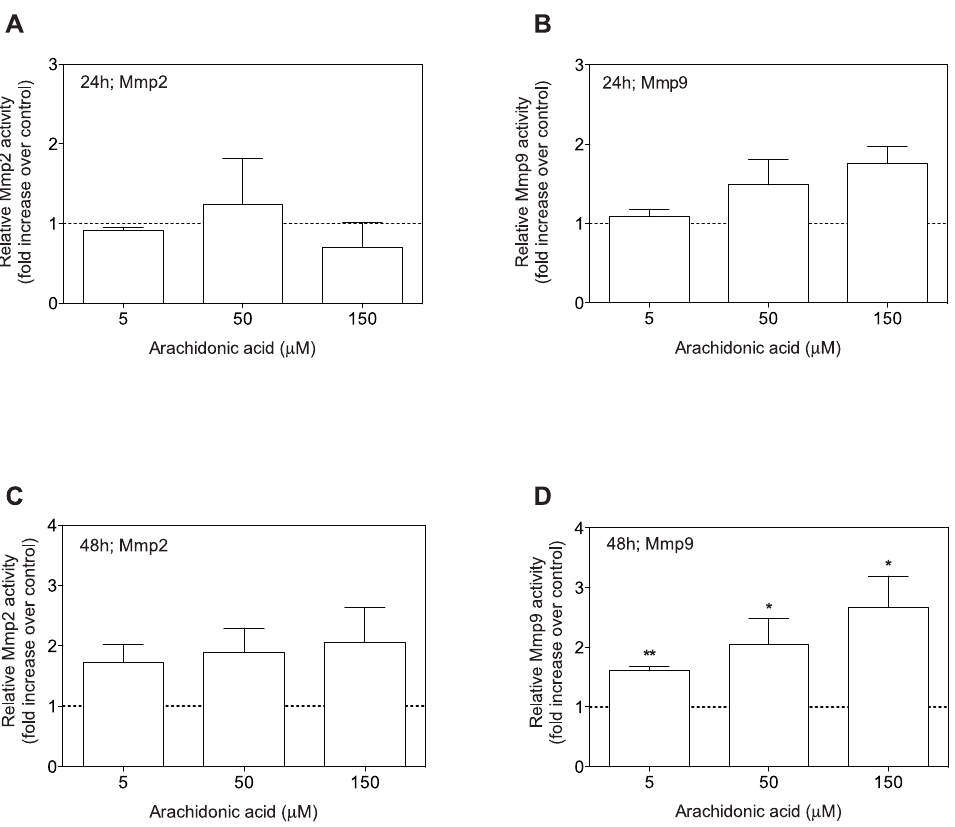
Figure 6. In-vitro exposure of scales to arachidonic acid. Semiquantitative analysis of gelatinolytic matrix metalloproteinases of culture medium after in vitro exposure of ARA for 24 hours ( A and B ) and 48 hours ( C and D ). A : ARA has no effect on Mmp2 activity after 24 hours of culture. B : A transient, non-significant increasing trend is measured in Mmp9 activity with increasing ARA concentration. C : Stimulatory effects of ARA on Mmp2 are not significant. D : ARA significantly increases MMP9 after 48 hours of culture, with a concentration-dependent trend. Activities of Mmp2 ( A , C ) and Mmp9 ( B , D ) are presented relative to the Mmp activity of samples taken from control cultures. Samples are expressed as mean 6 SEM of 2 (24 h) or 6 replicates (48 h). Statistical analysis was done with the Student’s t -test or Mann-Whitney U-test when results were not normally distributed (* p , 0,05, ** p , 0,01).